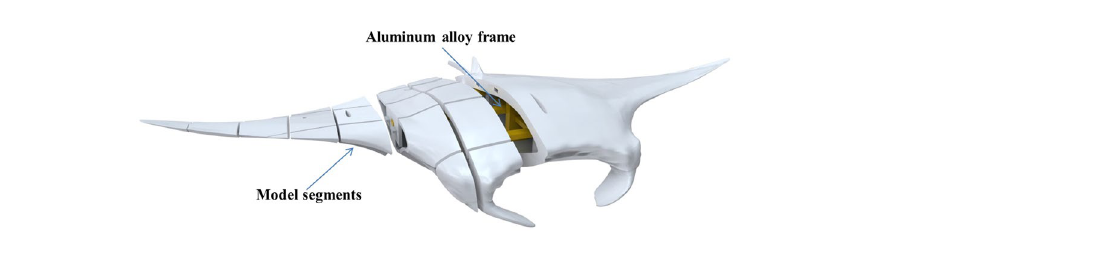
Figure 8. Schematic diagram of the 3D manta ray